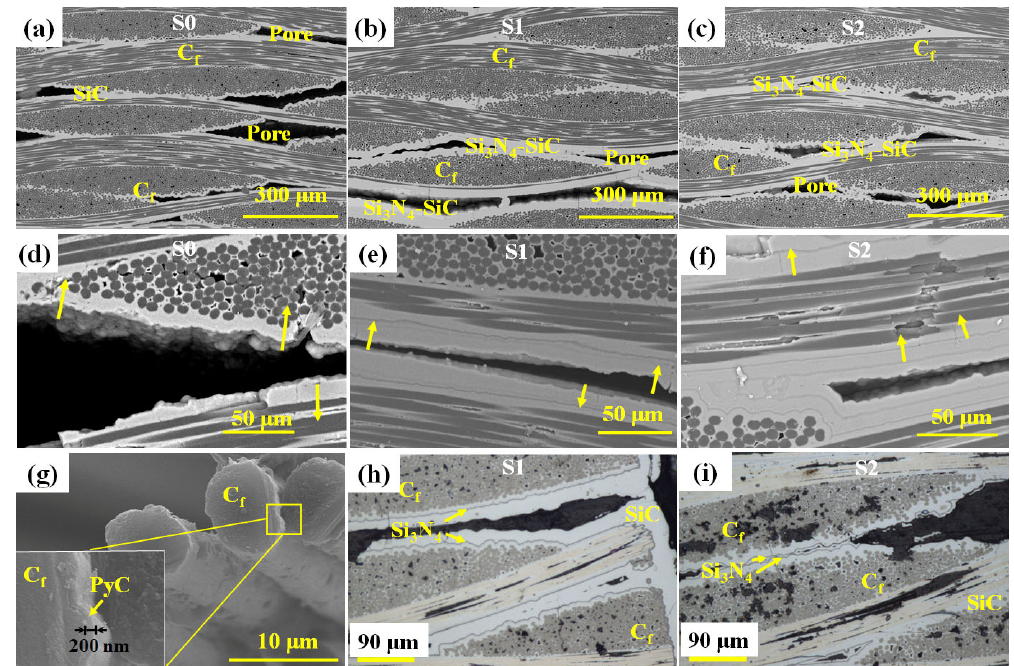
Fig. 2 Low-magnification and high-magnification BSE images of polished cross-sections of (a, d) sample S0, (b, e) sample S1, and (c, f) sample S2, respectively. (g) BSE images of the PyC interphase. The SPM images of (h) sample S1 and (i) sample S2 recorded by in-situ nanomechanical test